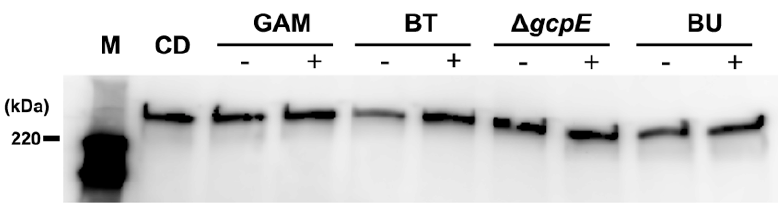
Figure 8. Lysozyme treatment reduced the suppressive effect of BT-derived PF on CD toxin pro- duction. PFs from either GAM broth or the culture supernatants of B. thetaiotaomicron VPI-5482 (BT), Tn 4351 -inserted gcpE mutant of BT ( Δ gcpE ), or B. uniformis ATCC8492 (BU) were treated with lysozyme. CD Toxin A production in the conditioned media, which contained PFs with or without lysozyme treatment (indicated by + and -, respectively), was compared. CD, CD culture supernatant in GAM broth; M, HRP-labeled protein size marker.